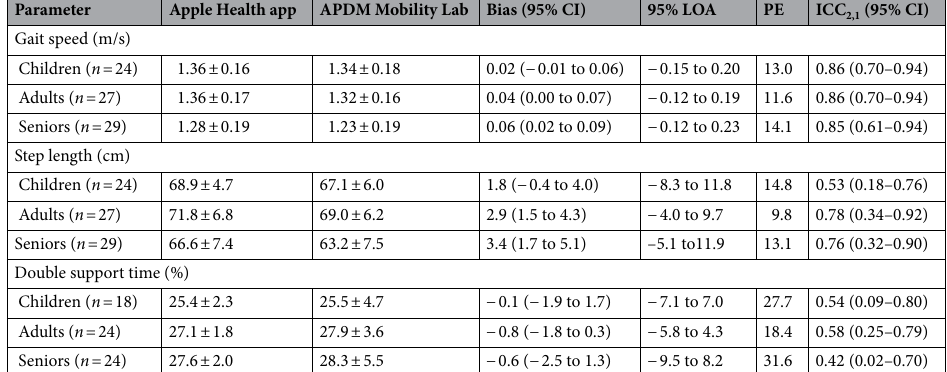
Table 2. Concurrent validity of the Health app with the APDM Mobility Lab. Descriptive data given as mean ± standard deviation. CI confidence interval, LOA limits of agreement, PE percentage error, ICC intraclass correlation